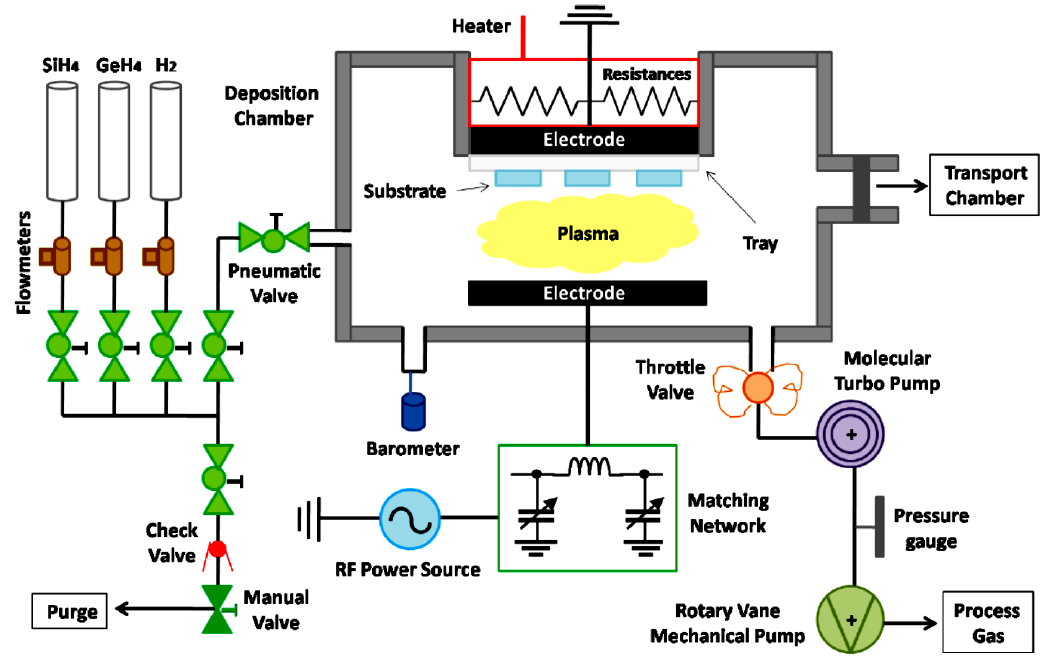
Figure A1. MVSystem Plasma Enhanced Chemical Vapor Deposition (PECVD) chamber configuration. Table B1. Peak assignments in FTIR spectra of the films studied.